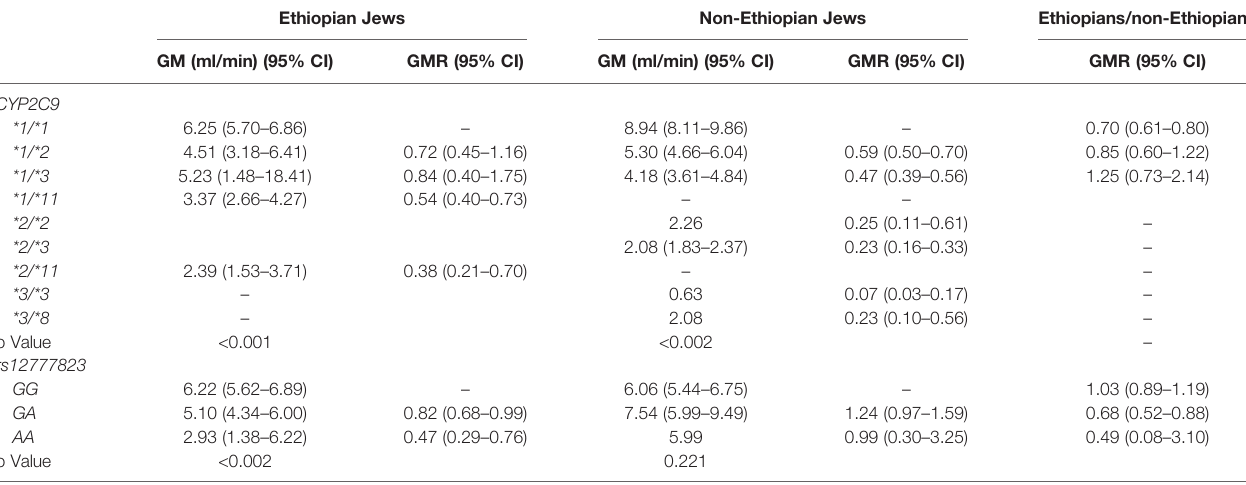
TABLE 4 | Phenytoin Metabolic Ratio 24/12 according to CYP2C9 and rs12777823 genotype in the Ethiopian and non-Ethiopian